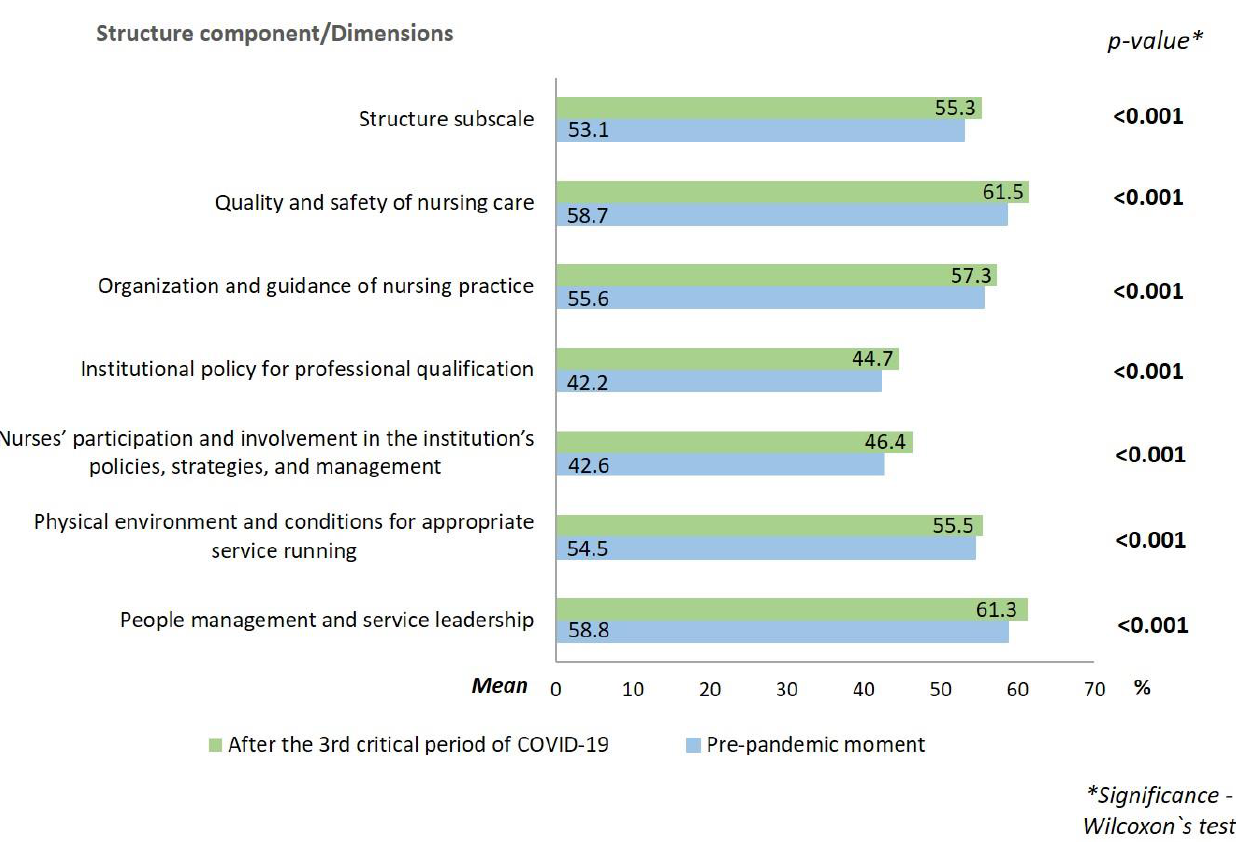
Figure 1. Mean scores of the structure component of nursing professional practice environments at the pre-pandemic moment and after the 3rd critical period of COVID-19.